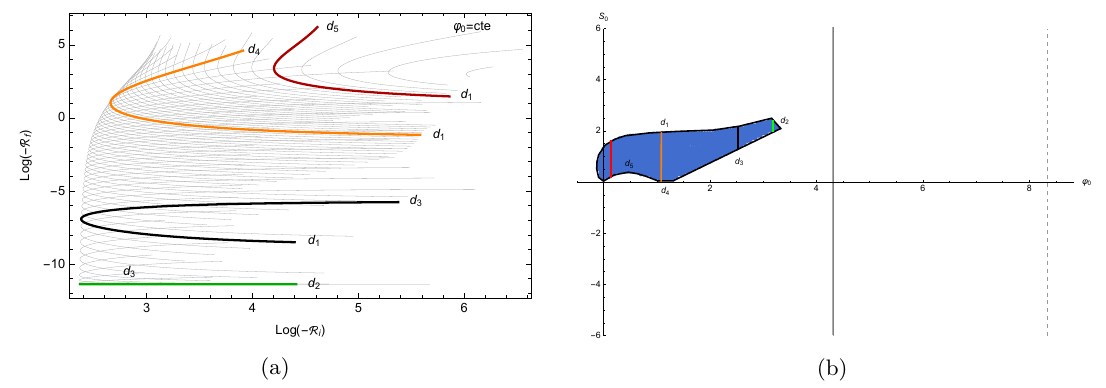
region we can read the behavior of R Figure 25 . In W LL 1 , 2 values of ϕ . The colored curves represent the generic behavior of the dimensionless curvatures 0 as we move between different boundaries of the space of solutions in figure (b). For the red curve , the orange curve ϕ = 11 , the black curve ϕ ϕ 0 = 1 0 10 10